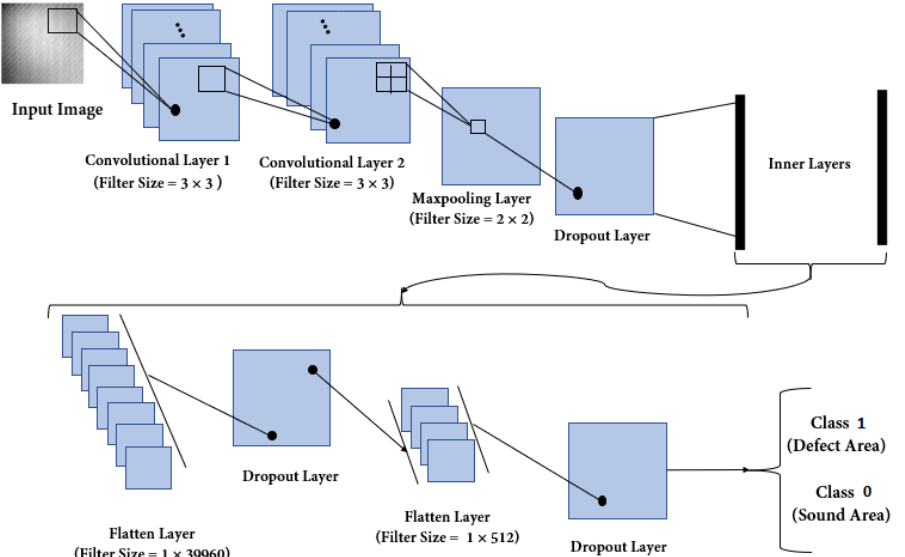
Figure 13. The CNN sequence to classify thermal Figure 13. CNN sequence to classify thermal images